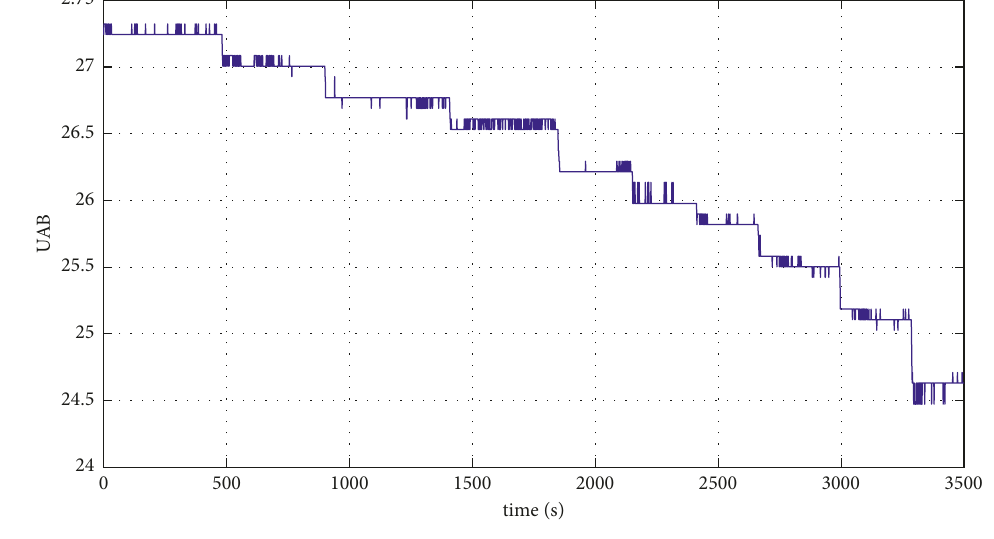
Figure 15: Line voltage U